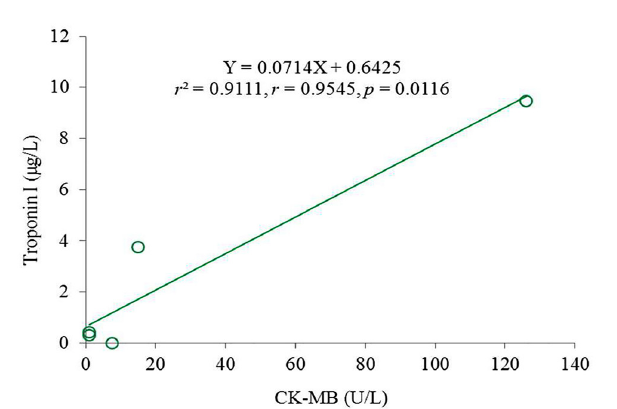
Fig. 2 - Linear correlation between troponin I and creatine kinase isoenzyme MB. CK-MB=creatine kinase isoenzyme MB.